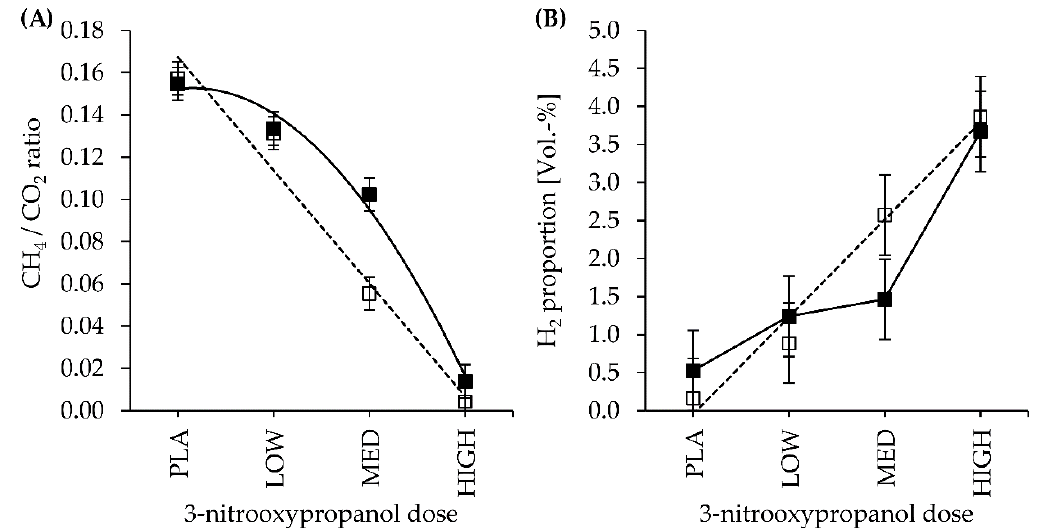
Figure 1. Effect of 3-nitrooxypropanol dose (PLA: 0, LOW: 73, MED: 160, and HIGH: 1200 mg of 3-NOP/kg of feed DM) and low- ( (cid:3) , dashed line) or high- ( (cid:4) , solid line) concentrate proportion in the incubated diet on ( A ) methane (CH 4 ) to carbon dioxide (CO 2 ) ratio and ( B ) hydrogen (H 2 ) proportion (Vol.-%) in fermentation gases; curve fitting according to (non)significant L and Q effects (Table 3).